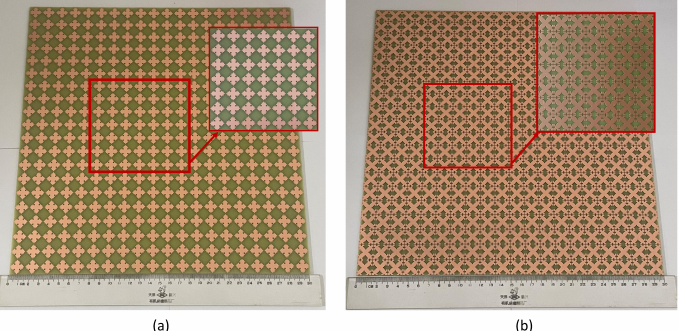
Figure 8. Fabricated optimized fractal FSS. ( a ) Top view, ( b ) Bottom